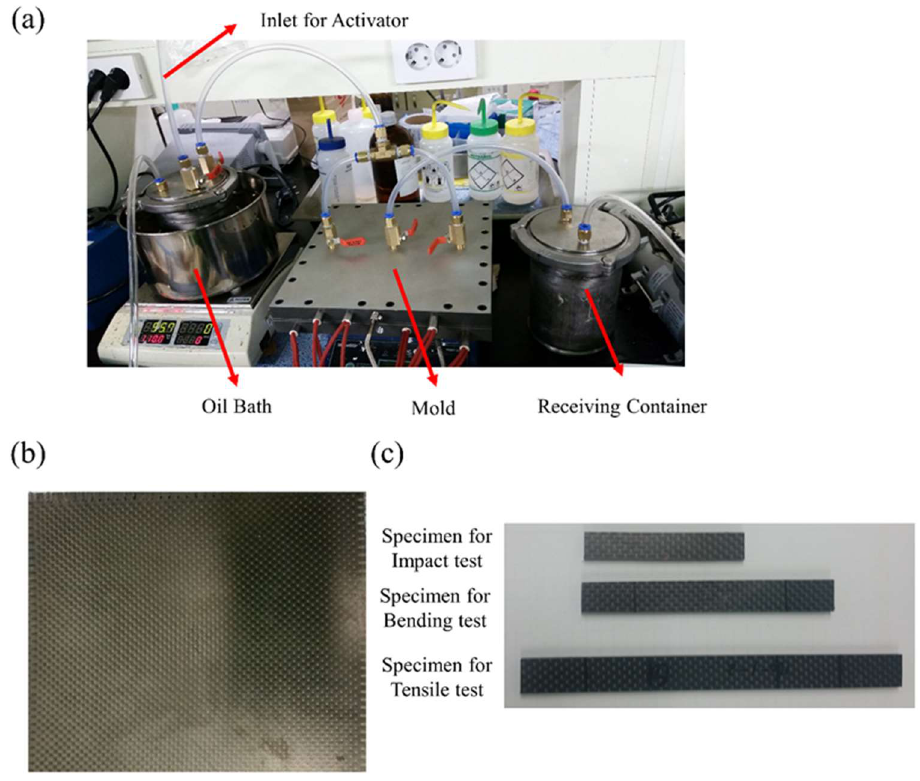
Figure 3. ( a ) Experimental setup for VARTM process; ( b ) carbon fiber-reinforced polyamide 6 sam-